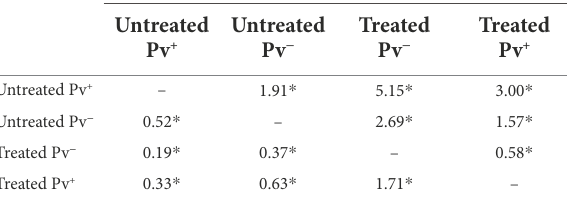
TABLE 2 Hazard ratio estimated by Cox model until 14 days post